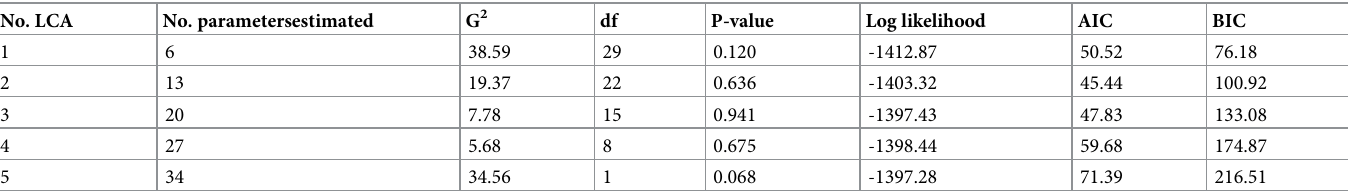
Table 4. Comparison of LCA models with different latent classes based on model selection statistics.